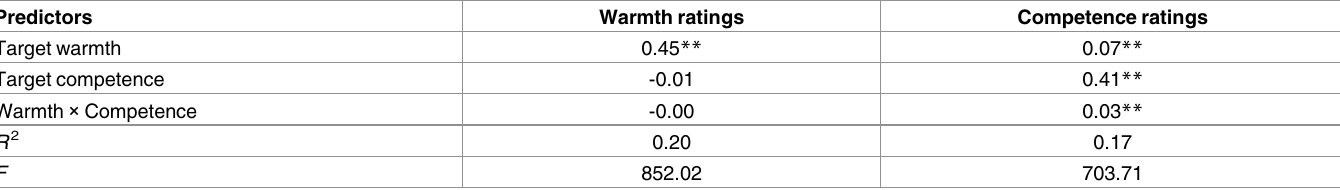
Table 2. Standardized beta coefficients for the predictors of perceived warmth and